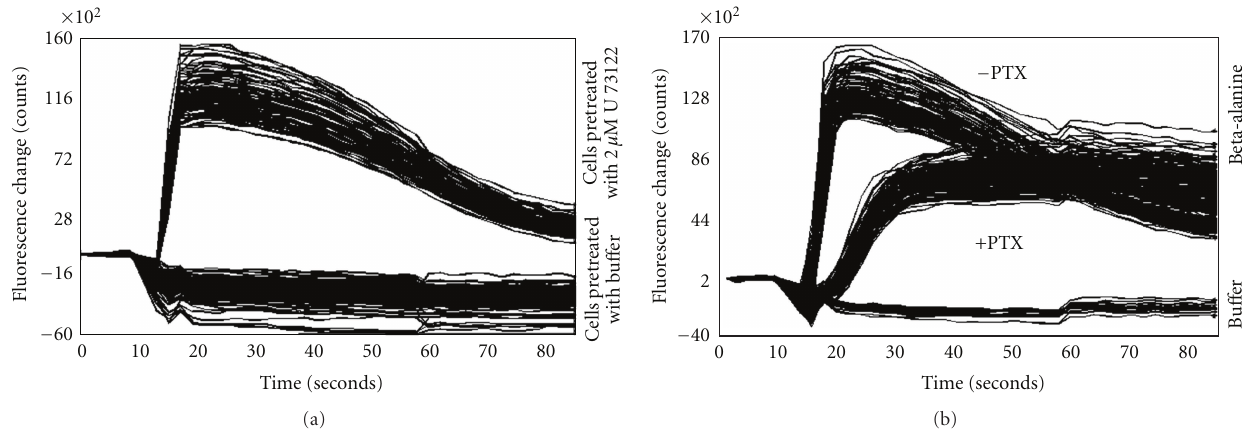
Figure 2: Evaluation of Gq (Figure 2(a)) and Gi (Figure 2(b)) coupling of MrgD receptors assessed using FLIPR response. MrgD cells were pretreated with the PLC inhibitor (U-73122 at 2 μ M for 30 or 60 minutes) or pertussis toxin (100ng overnight) for blocking Gi coupling to MrgD. FLIPR responses were evaluated by the addition of 100 μ M beta-alanine.